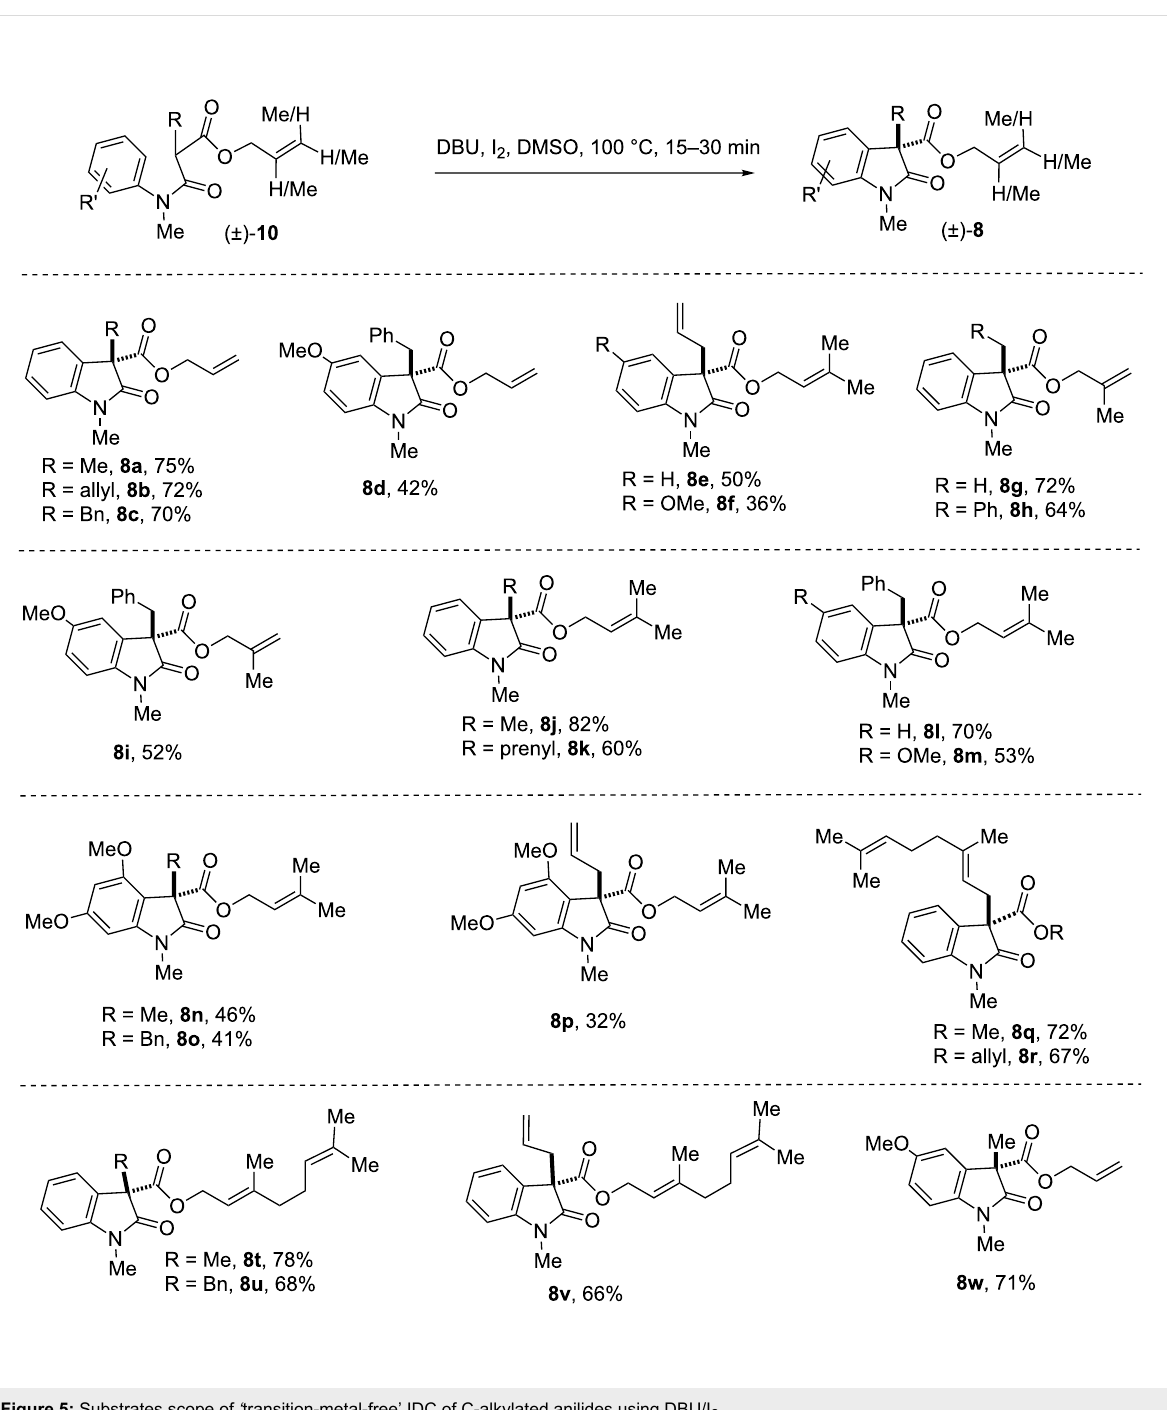
Figure 5: Substrates scope of ‘ transition-metal-free’ IDC of C-alkylated anilides using DBU/I 2 .